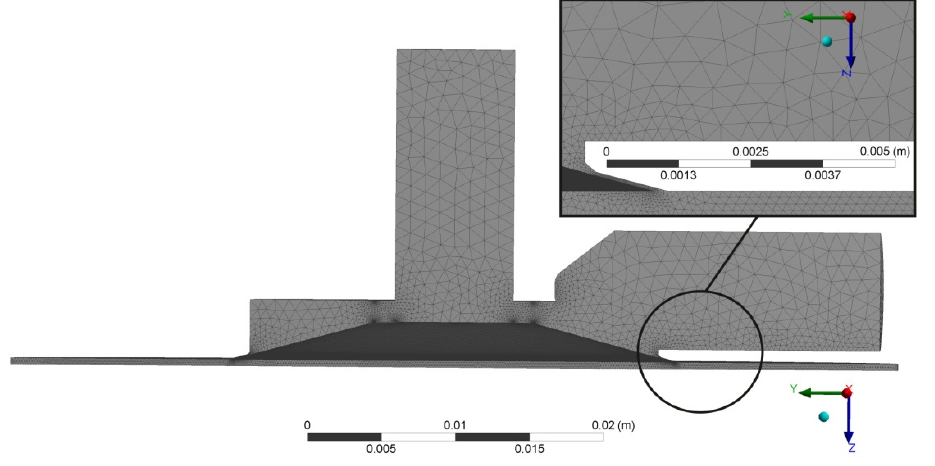
Figure 4. Scheme follows the same formatting settlement grid of the final elements of the air flow at h c = 0.4 mm.